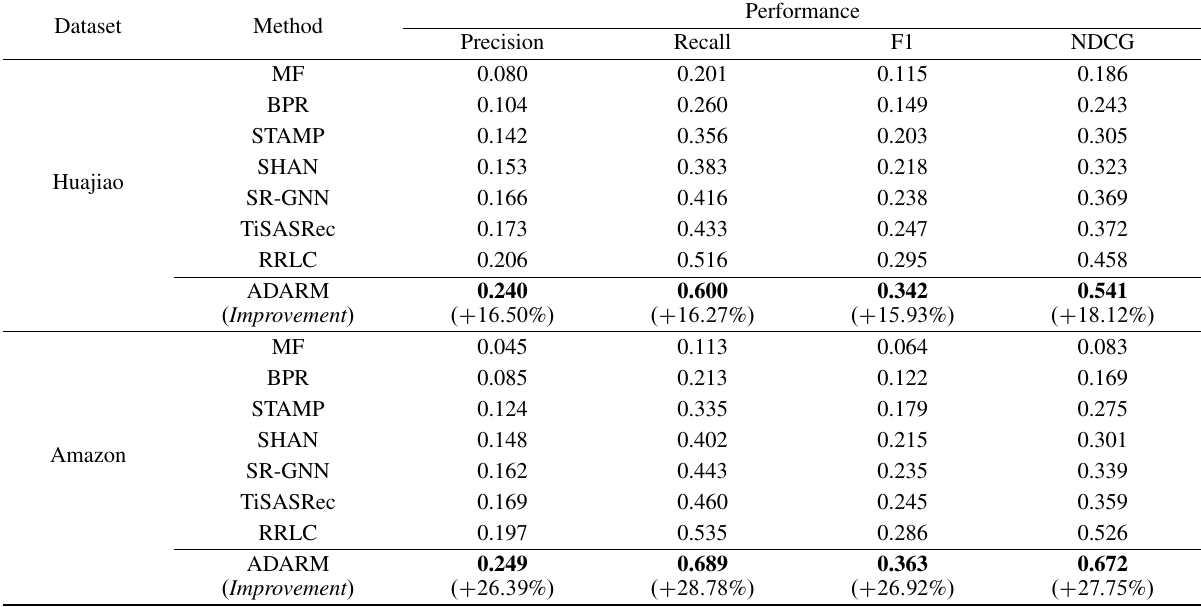
Table 5 Performance comparison among different models for top 5 recommendations.